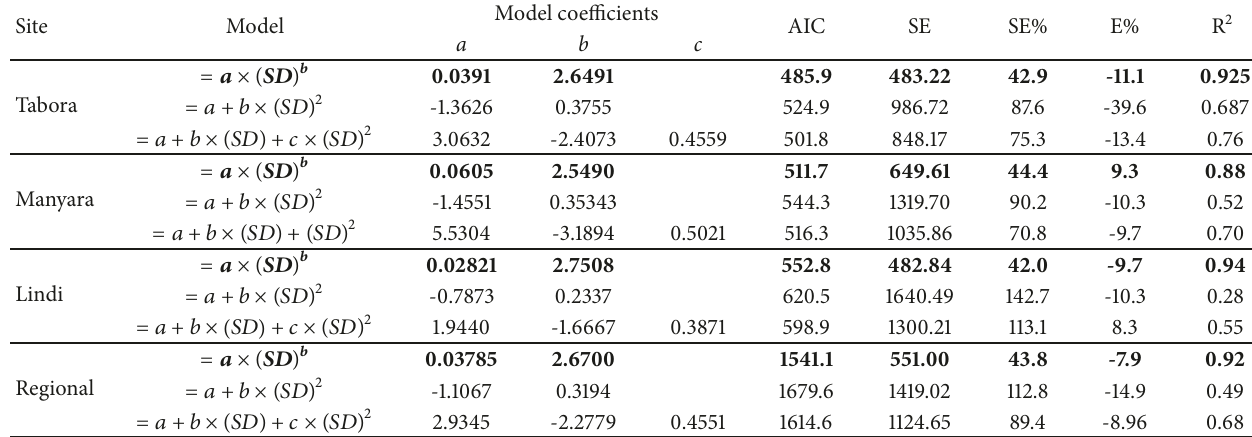
Table 5: Aboveground biomass model coefficients and performance.